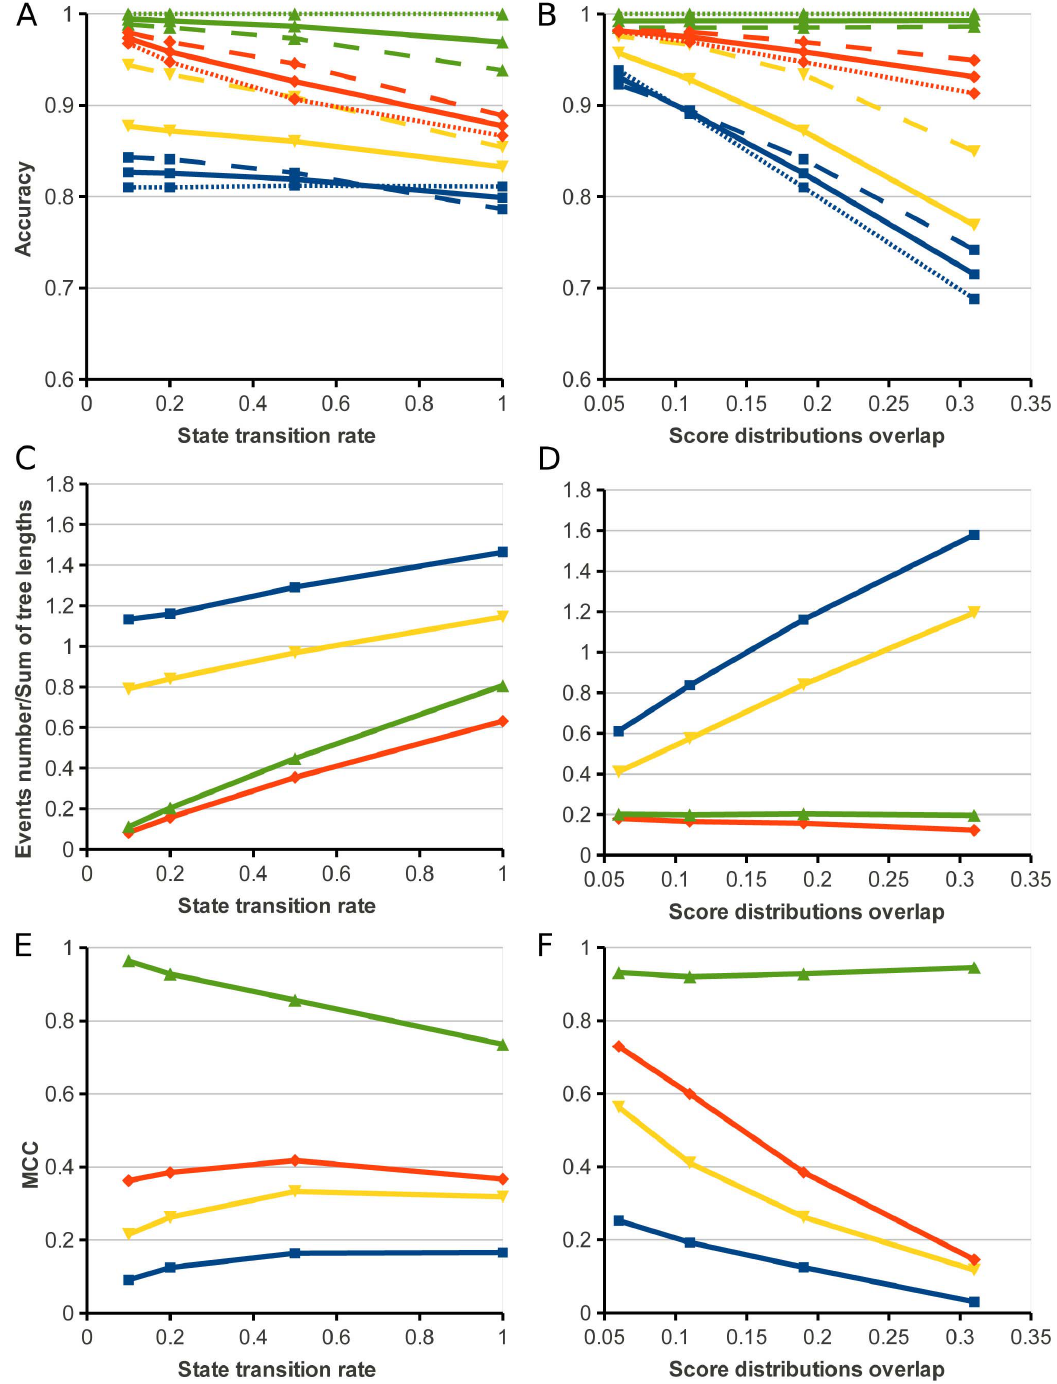
Figure 3. The comparison of the tHMM, dumbtHMM and BayesTraits on simulated data sets. ( a ) The nodes, leaves and total accuracy of states reconstruction for simulations with varying transition rates and with fixed score distributions overlap value=0.19. ( b ) The nodes, leaves and total accuracy of states reconstruction for fixed transition rate=0.2 and varying score distributions overlap values. The red lines represent the tHMM results; the blue lines, BayesTraits results; the yellow lines, the results of dumbtHMM; and the green lines represent the results of the dumbtHMM reconstruction from the known assignment of states to leaves. The dashed lines show the accuracy for internal nodes reconstruction; the dotted line, the accuracy of leaves assignment (the yellow dotted line coincides with the blue dotted line); and the solid line, the mixed accuracy for all the nodes of the tree. ( c ) The number of reconstructed events normalized by the total tree length in the set for the same settings as in ( a ). ( d ) The number of reconstructed events normalized by the total tree length in the set for the settings as in ( b ). In ( c ) and ( d ), the green line represents the real number of events; the blue line, the number of events reconstructed by the BayesTraits algorithm; the red line, by the tHMM algorithm; and the yellow line, by the dumbtHMM algorithm. ( e ) The Matthews correlation coefficient(MCC) for the accuracy of events reconstruction for the same settings as in ( a ). ( f ) The MCC for the accuracy of events reconstruction number of reconstructed events for the settings as in ( b ). In ( e ) and ( f ), the green line represents